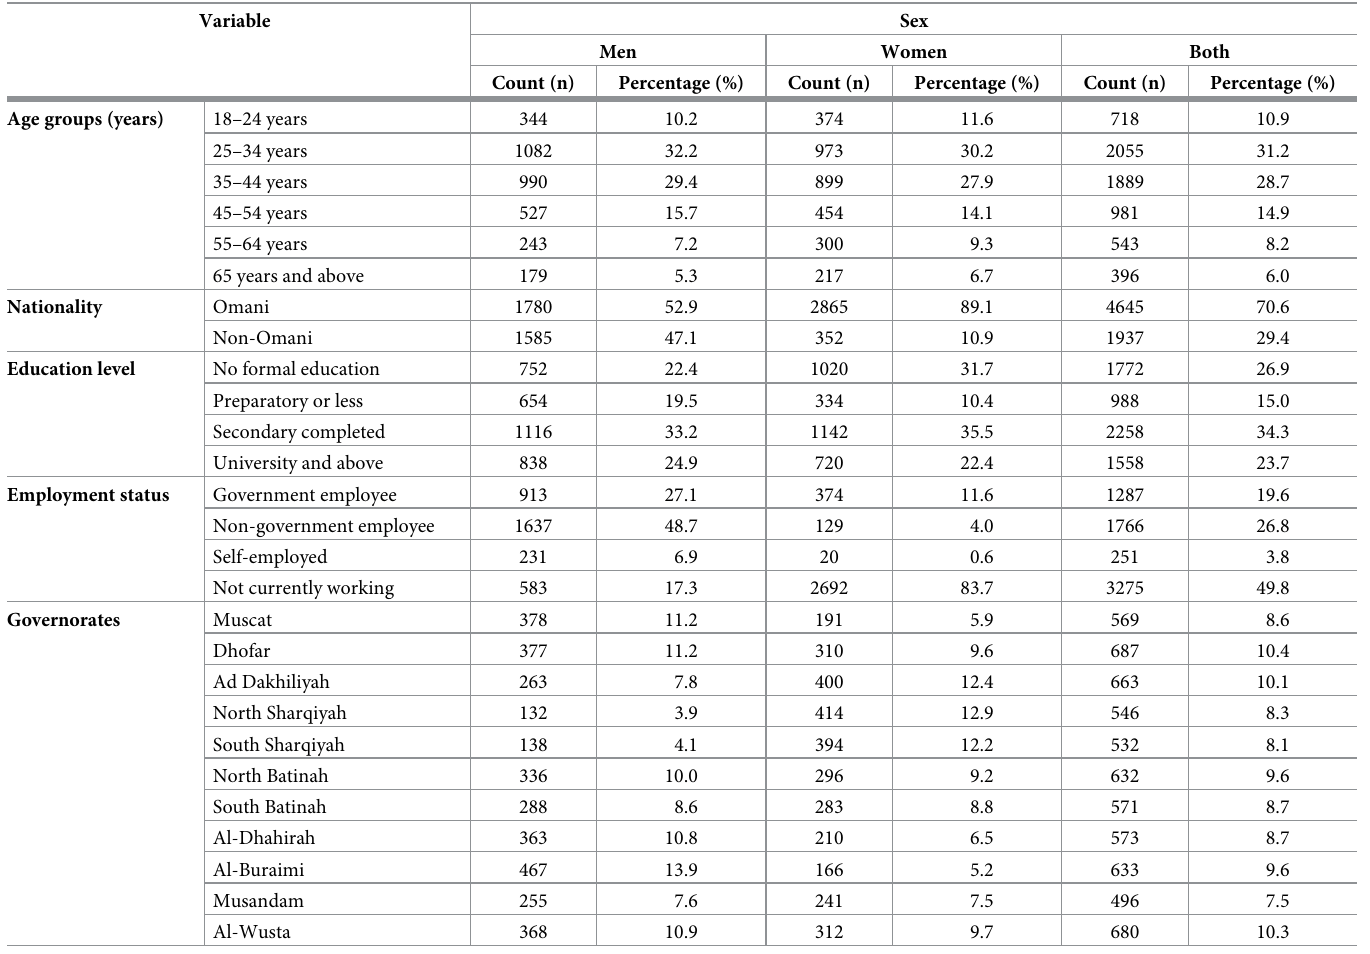
Table 1. Socio-demographic profile of the study population stratified by